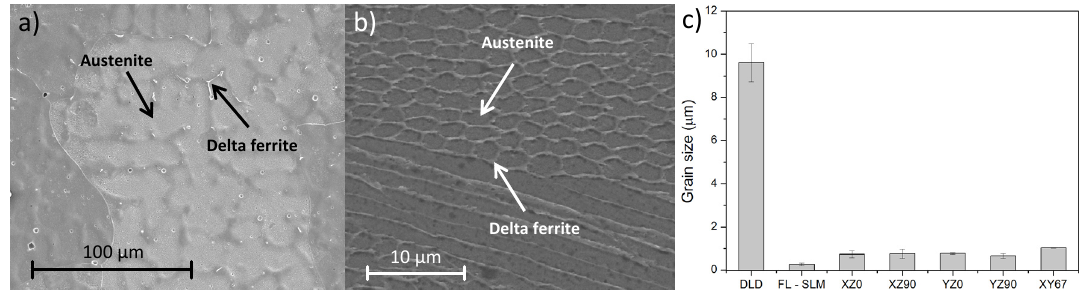
Figure 6. SEM micrograph of samples: ( a ) DLD; ( b ) FL–SLM; and ( c ) grain sizes measured in the samples.